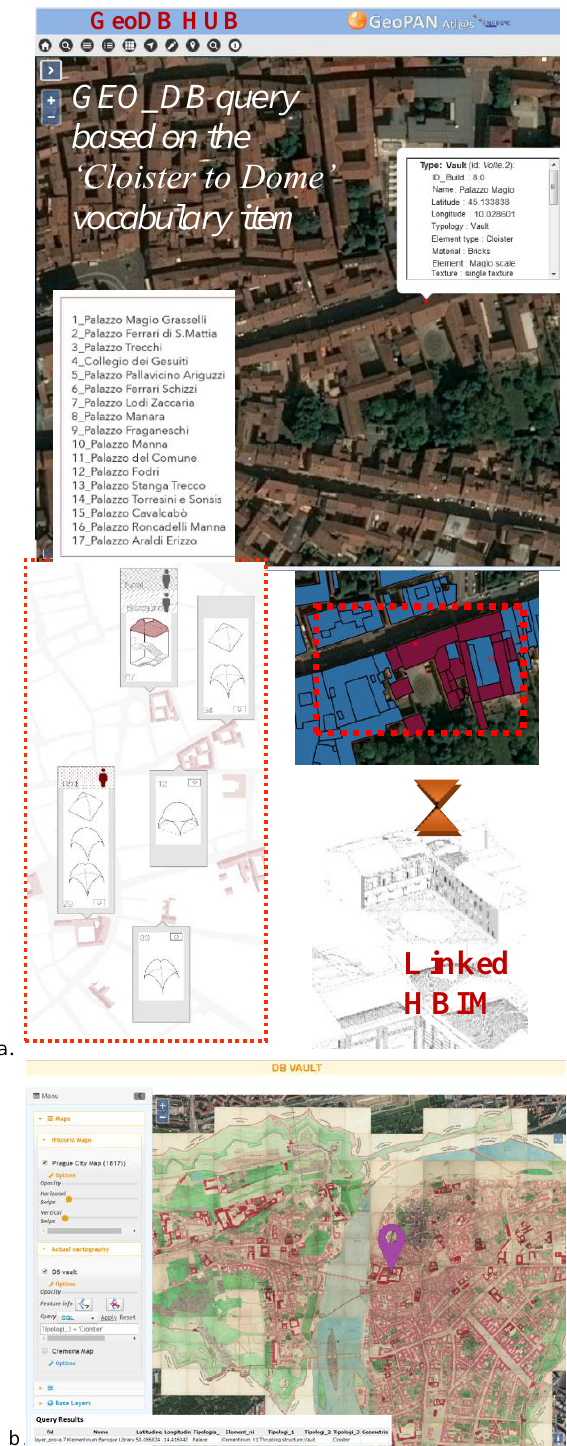
Figure 7 .The GeoPAN APP (GeoDB Hub): (a) the vault inventory of the Cremona Palaces entered in the Data Model and the vault DB queried for a specific vocabulary item (i.e. the ‘Cloister to Dome’ search typology): the returned ID_08, Palazzo Magio, Cremona (Italy), with the linked 3DHBIM model, and its DB contents on the vaulted systems; and (b) a similar query in for the area of Prague connecting the historic map of the city and the building vaults surveyed and classified.